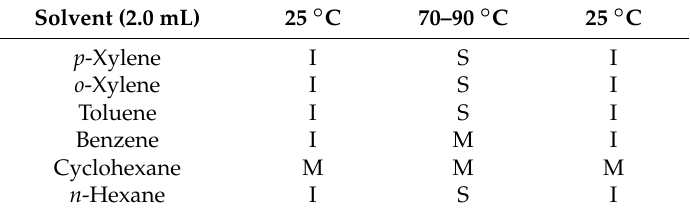
Figure 2. Photographs of thermoregulated phase separated catalysis (TPSC)-based ICAR-ATRP (initiators for continuous activator regeneration-atom transfer radical polymerization) in PIL/benzene biphasic solvent system. Table 1. Selection of organic solvents with PIL (174 mg) for the TPSC-based polymerization a .